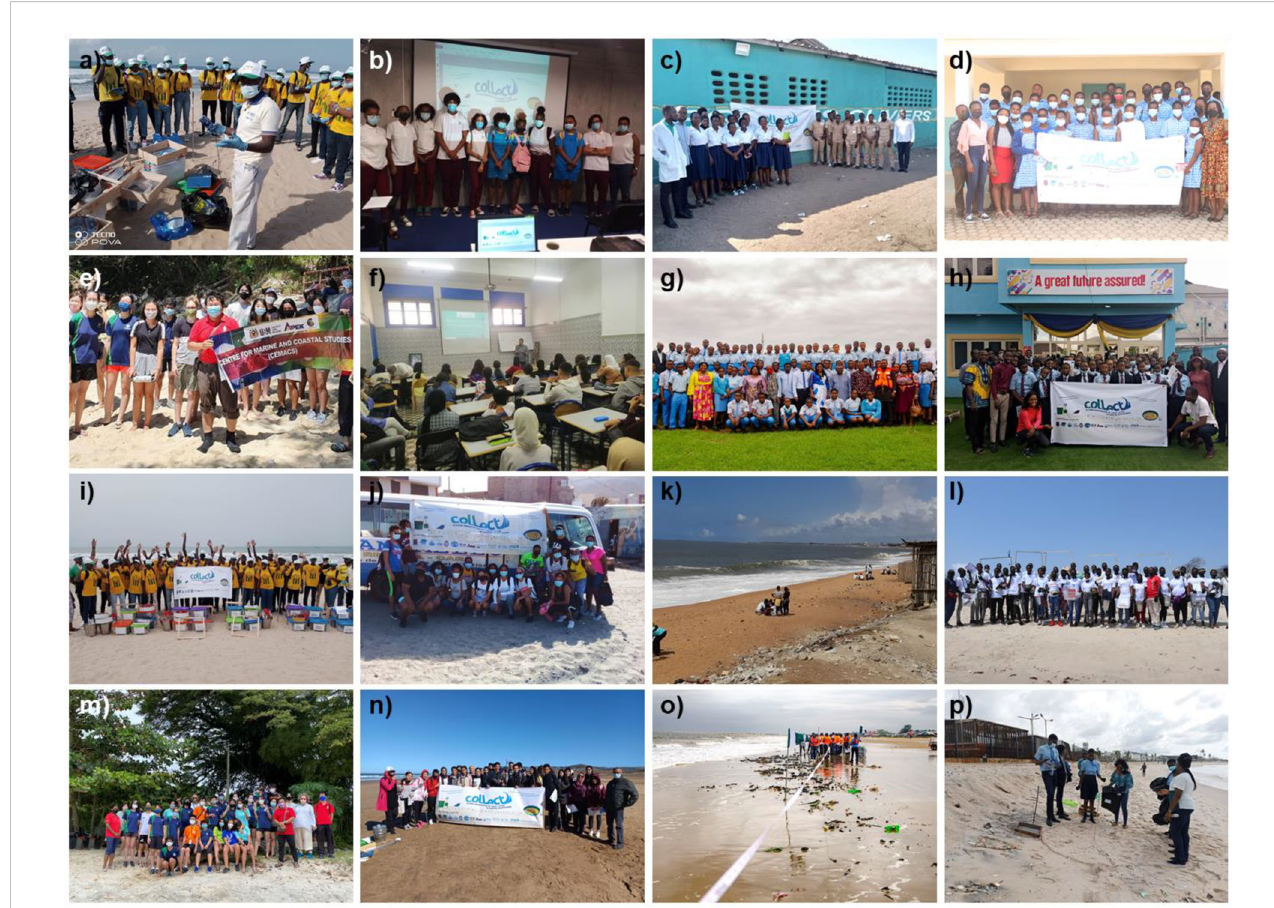
FIGURE 4 Images of the COLLECT activities at school during information sessions (most photos from fi rst two rows) and during fi eld activities (bottom two rows), in: (A, I) Benin (both during fi eld activities); (B, J) Cabo Verde; (C, K) Co ̂ te d ’ Ivoir; (D, L) Ghana; (E, M) Malaysia (both during fi eld activities); (F, N) Morocco; (G, O) Calabar, Nigeria; (H, P) Lagos, Nigeria. Please refer to the main text and the Supplementary Information for further details on the information session ’ s format and content, including the banner